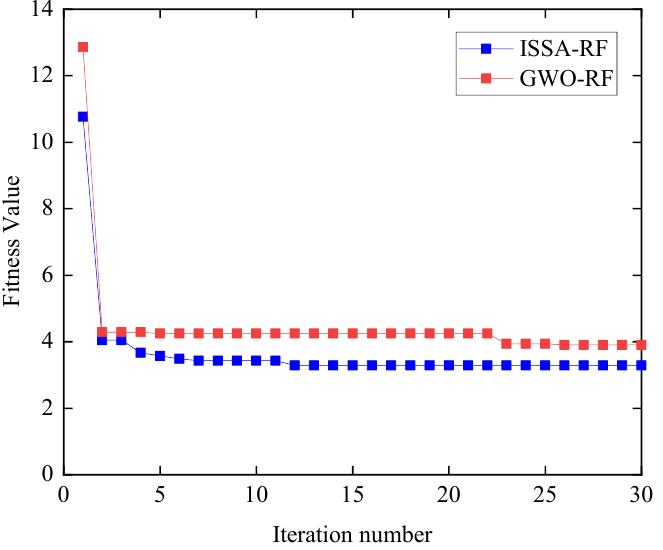
Figure 12. Comparison of convergence performance based on ISSA and GWO optimization algo- rithms.